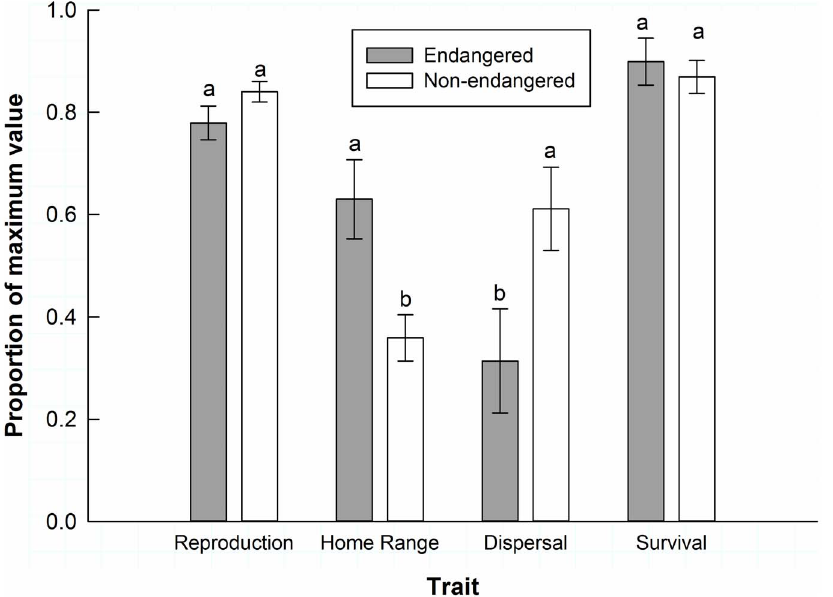
Figure 2. Ecological trait values. Mean ecological trait values ( 6 SE) in threatened and endangered subspecies (shaded bars) and non-listed subspecies (white bars) for litter or clutch size, home range size, dispersal distance, and annual adult survival. Data were transformed to proportions of the maximum value for each taxon-pair x trait combination. For each trait, bars with different letters are significantly different (p , 0.05).